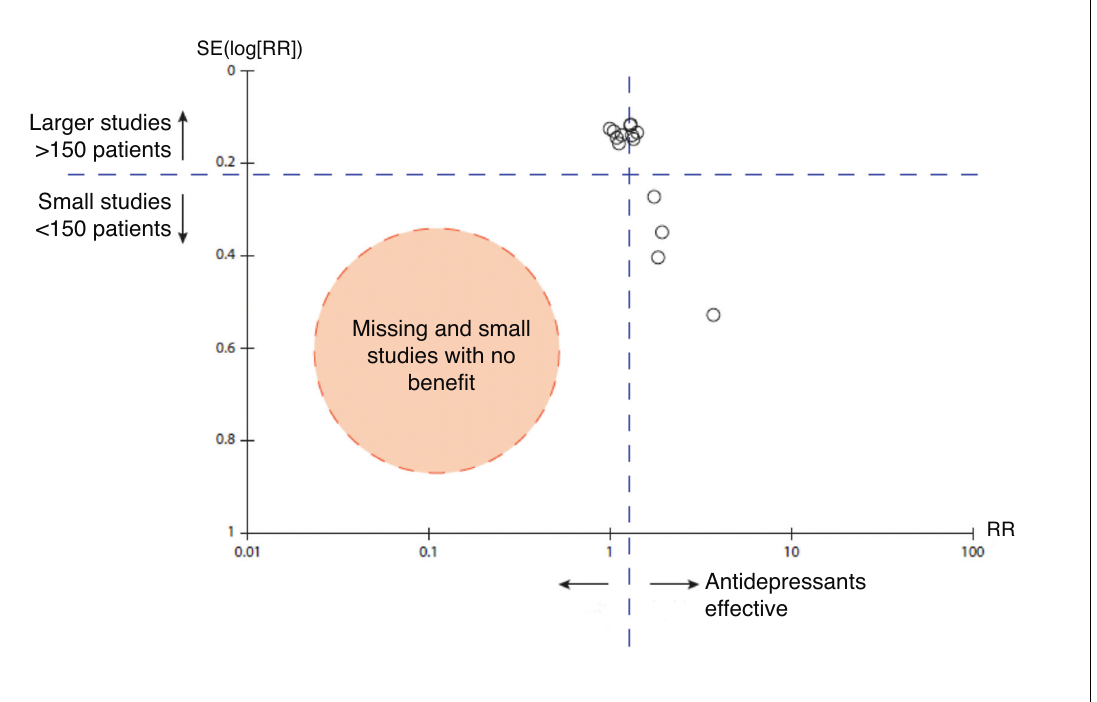
Figure 1. Funnel plot of SSRI and TCA versus placebo from primary care antidepressant versus placebo review.